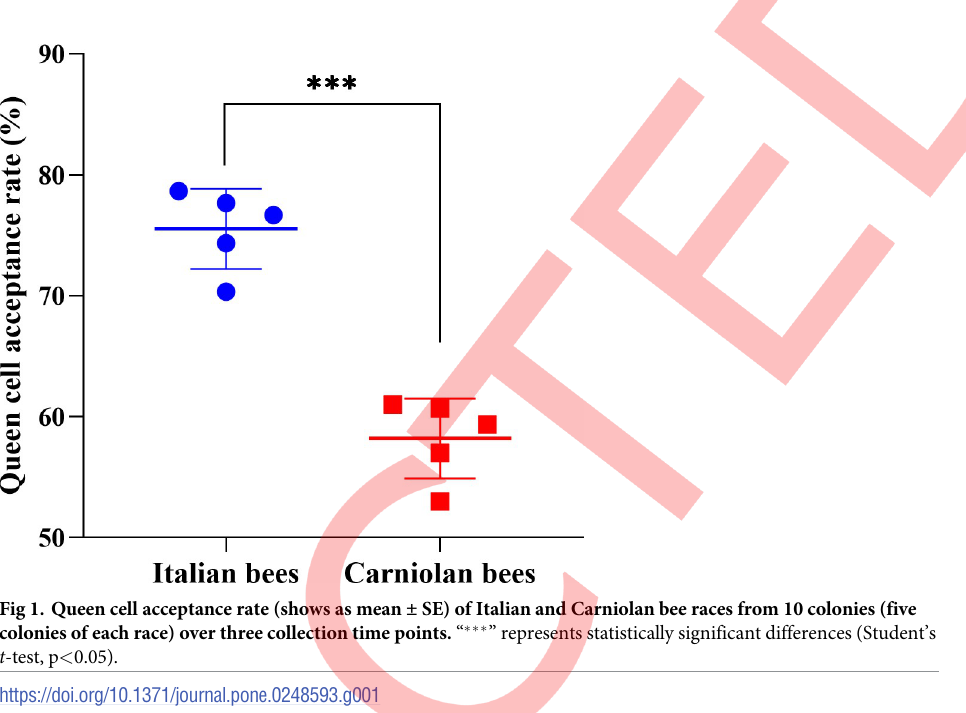
Fig 1. Queen cell acceptance rate (shows as mean ± SE) of Italian and Carniolan bee races from 10 colonies (five colonies of each race) over three collection time points. “ ��� ” represents statistically significant differences (Student’s t -test, p < 0.05).